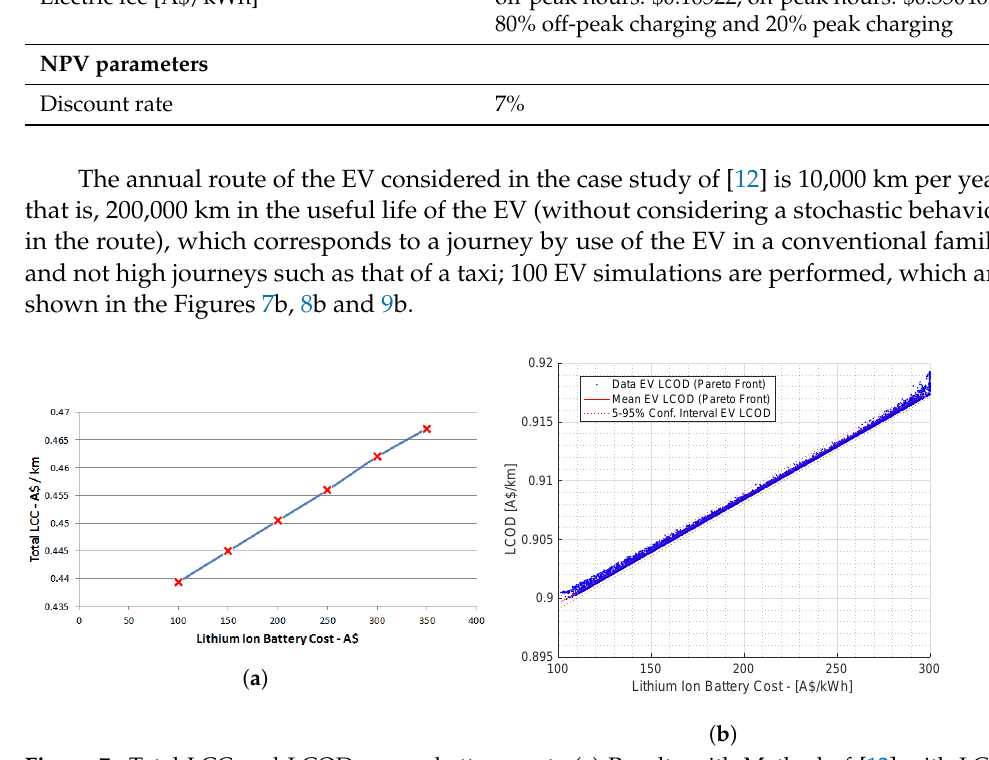
Figure 7. Total LCC and LCOD versus battery cost. ( a ) Results with Method of [12] with LCC. ( b ) Results with proposed method (LCOD).